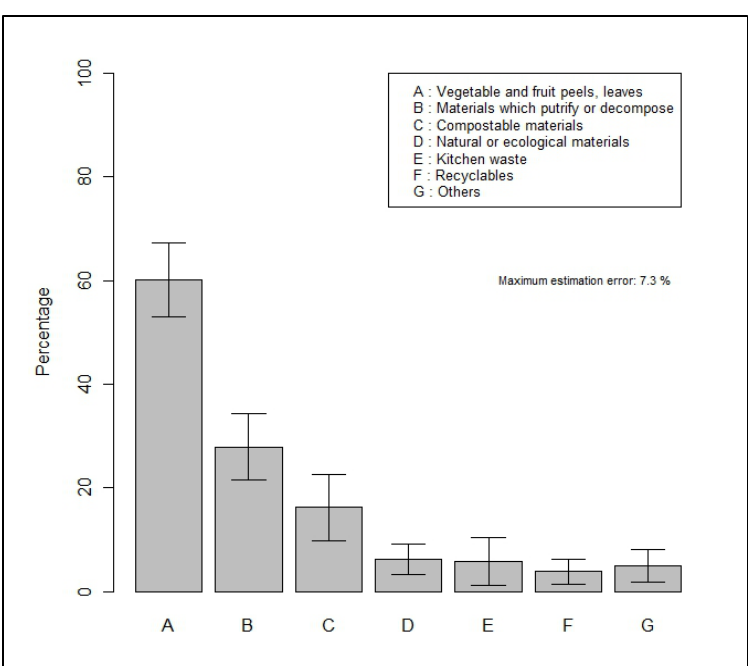
Figure 3. San Cristobal Respondents’ Definitions of Organic Waste (n=209)